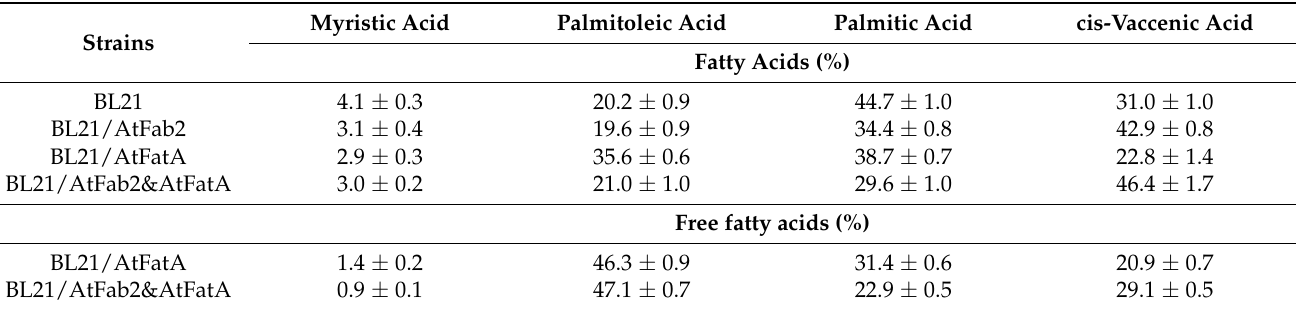
Figure 5. Gas chromatograms of fatty acid methyl esters obtained from different E. coli strains. ( A ), the control strain harboring pET30a(+); ( B ), the pET-AtFab2 transformants; ( C ), the pACYC-AtFatA transformants; ( D ), E. coli strain harboring both pET-AtFab2 and pACYC-AtFatA; ( E ), FFAs from the pET-AtFatA transformant; ( F ), FFAs from E. coli strain harboring both pET-AtFab2 and pACYC-AtFatA. The retention times of the fatty acid methyl esters were as follows: myristic acid, 10.48 min; palmitoleic acid, 12.33 min; palmitic acid, 12.55 min; cis-vaccenic acid, 14.24 min. Table 2. Fatty acid compositions of different E. coli strains.